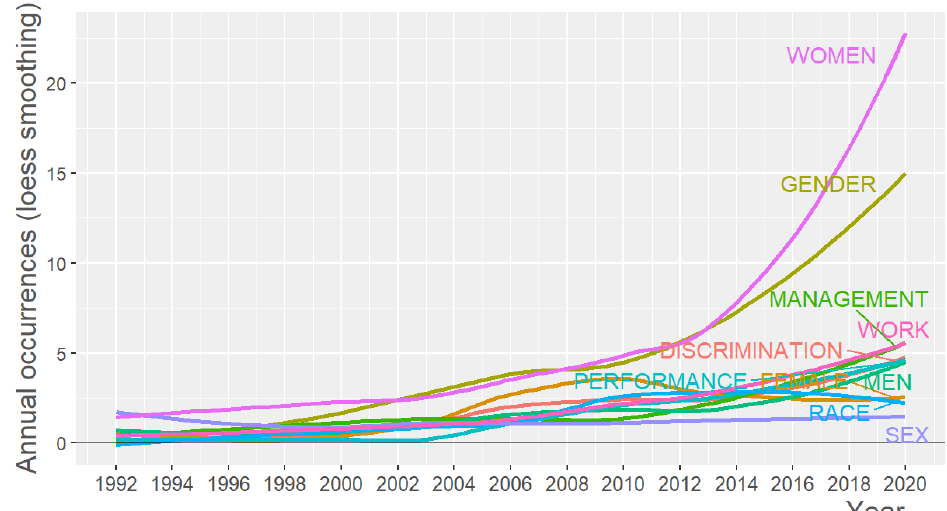
Figure 5. Word cloud.